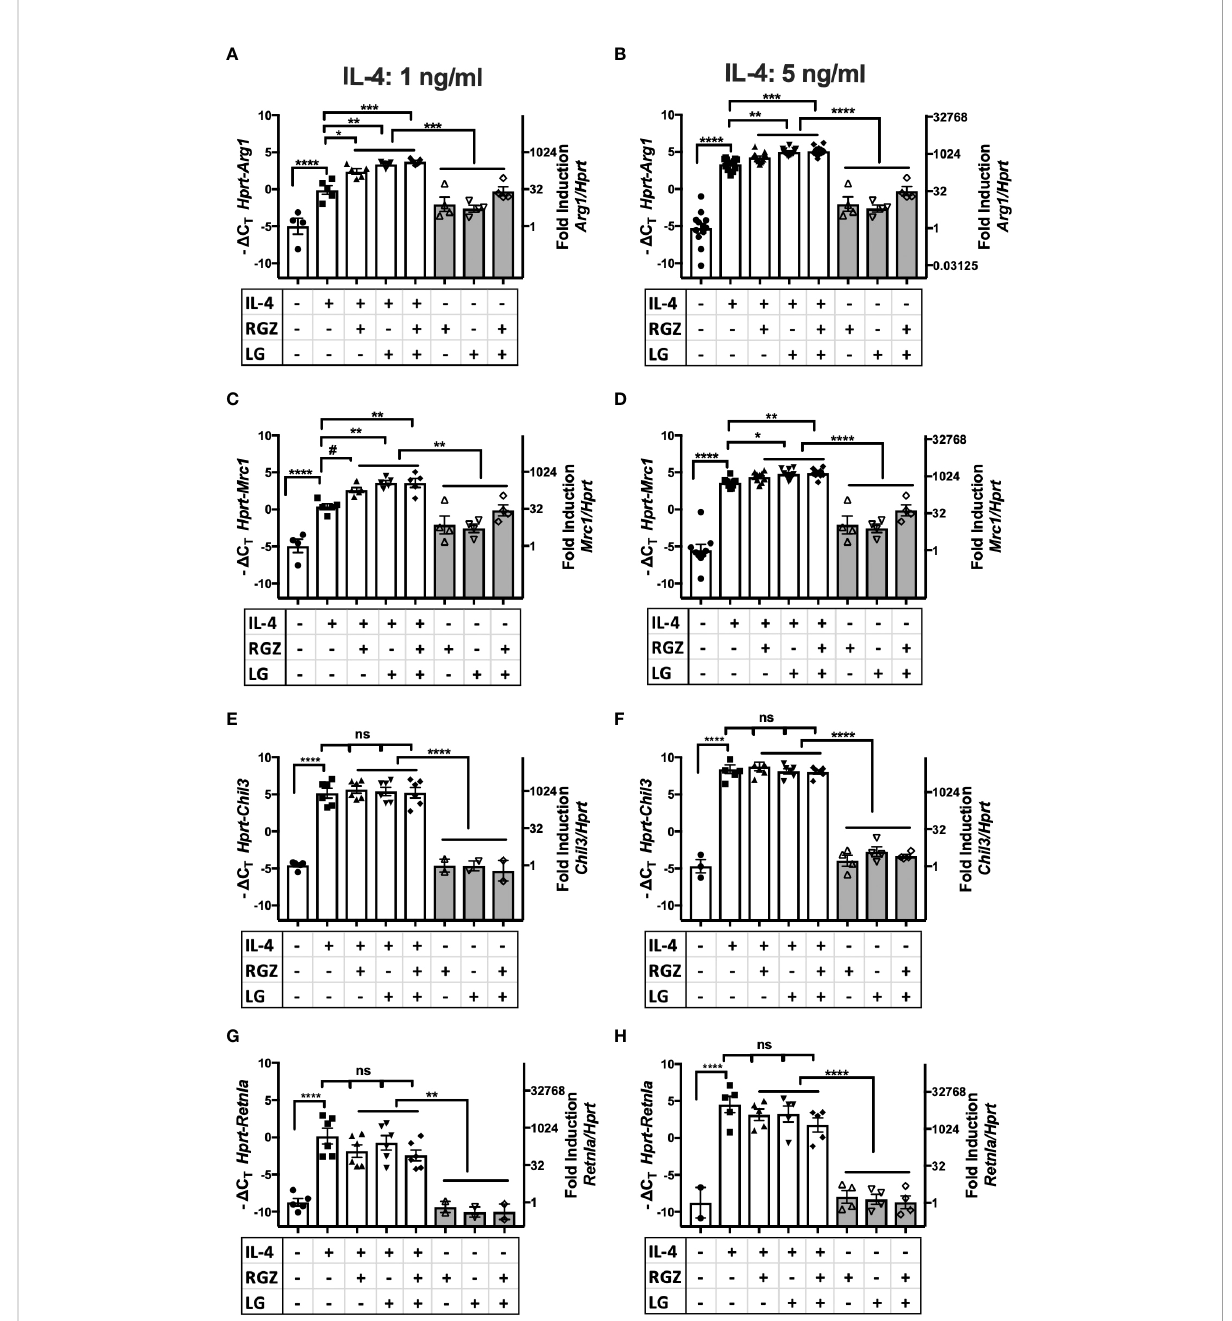
FIGURE 4 Effect of IL-4, PPAR g and RXR agonists on M2 macrophage gene expression using C57BL/6J peritoneal macrophages. Thioglycollate-elicited peritoneal macrophages were harvested from 6-8 week old WT C57BL/6J mice and stimulated with IL-4 at different concentrations (A, C, E, G) 1 ng/ml; (B, D, F, H) 5 ng/ml) in the absence or presence of 1 µM of rosiglitazone (RGZ) (PPAR g ligand) and/or 1 µM of LG100754 (LG) (RXR ligand) for 48hr, and RNA was processed as described in Methods . Gene expression was quamti fi ed by qRT-PCR.Data were pooled from 5-9 independent experiments and is presented as - D C T (left y-axis) and fold induction (2 - DD CT value; right y-axis), mean ± SEM. Statistical analysis (one-way ANOVA with Tukey ’ s multiple comparison post-hoc test) was performed on the - D C T values. ****p <0.0001, ***p<0.001, **p<0.01, *p<0.05, and # p=0.054. ns, not signi fi